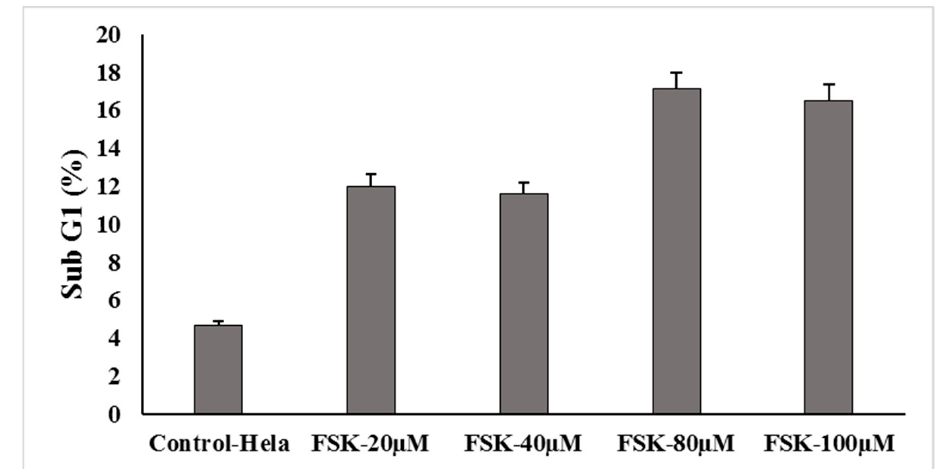
Figure 5. Cell cycle analysis. The graph depicting the percentage of apoptosis with treatment of Forskolin.